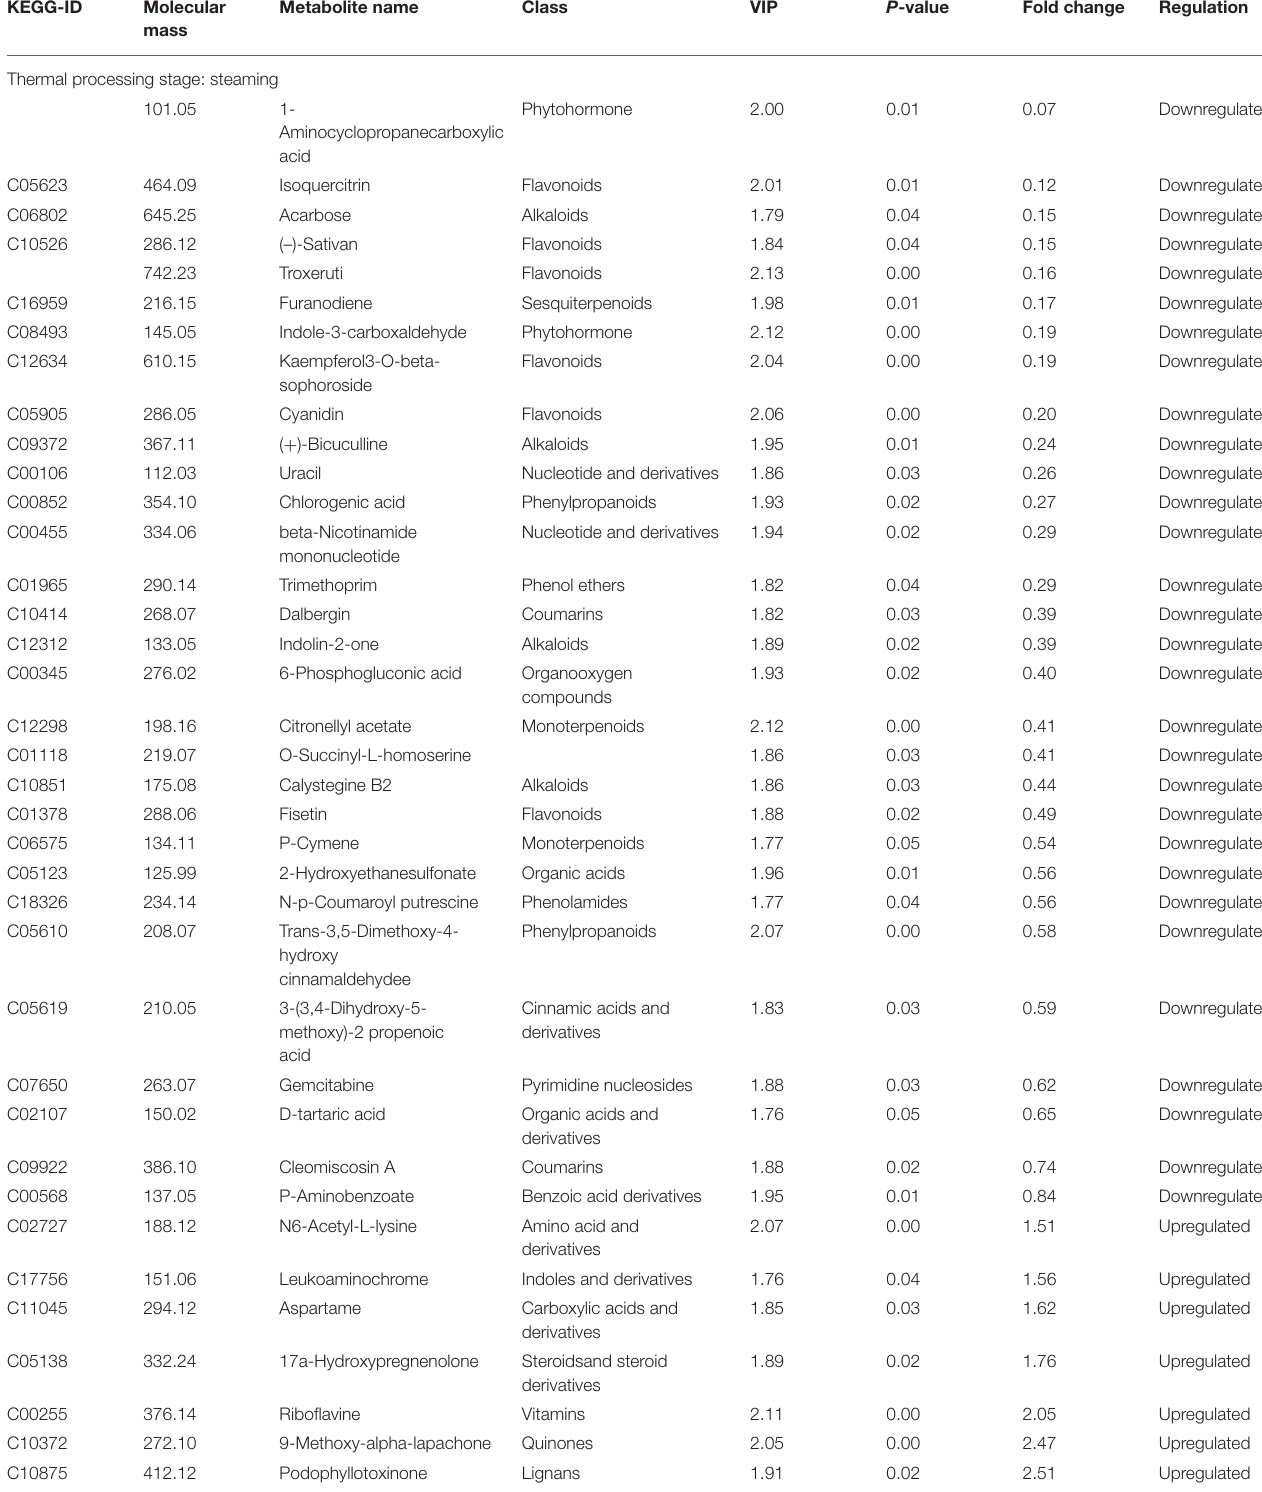
TABLE 1 | List of significantly different metabolites up/downregulated in Cistanche deserticola under different thermal processing stages.